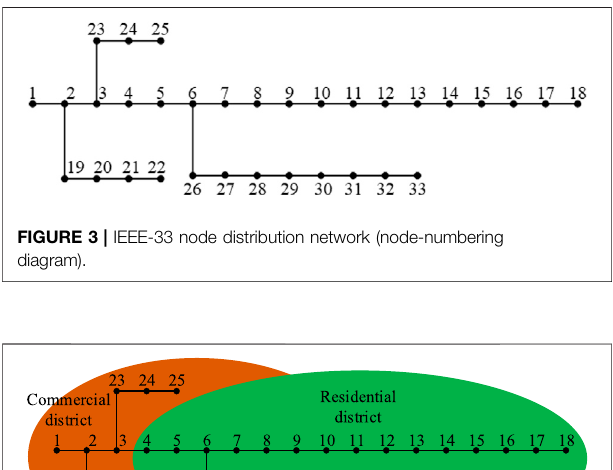
FIGURE 5 | Baseline load